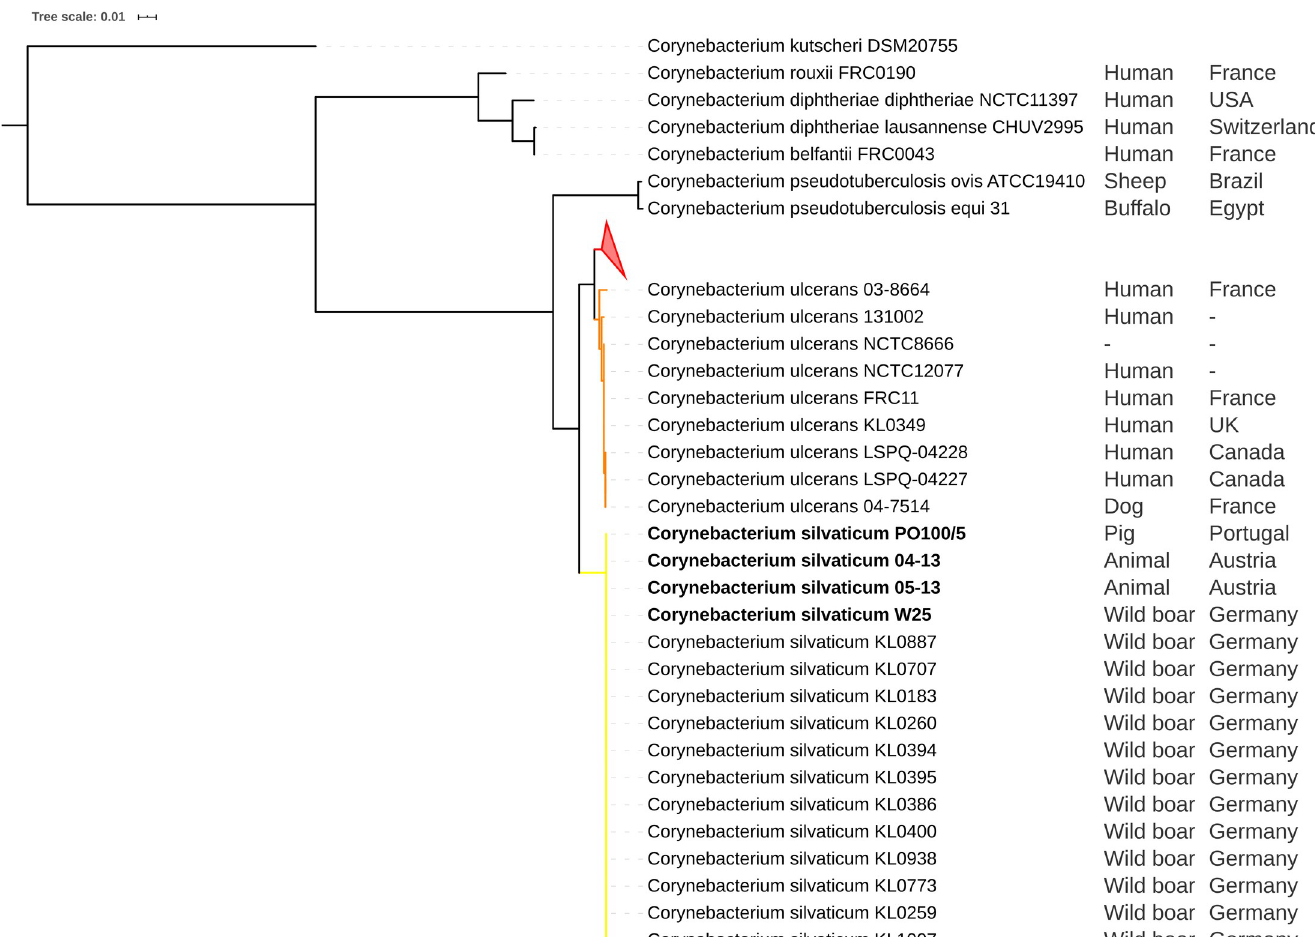
Fig 1. Phylogenetic tree of rpoB gene from Corynebacterium species. The phylogeny was inferred using the Maximum Likelihood method and the Tamura-Nei (TN93 + G) model implemented in the Mega v10.1.6. The Corynebacterium ulcerans strains PO100/5, 04–13, W25 and 05–13 cluster with the Corynebacterium silvaticum KL0182 T (yellow). C . ulcerans strains form lineage 1 (red, collapsed) and lineage 2 (orange).